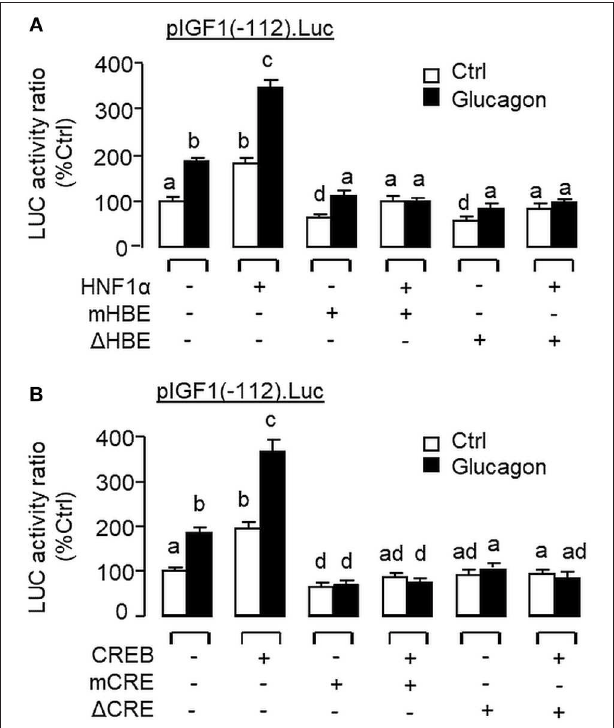
FIGURE 14 | Functional role of HBE and CRE sites within the proximal promoter of IGF-I gene in glucagon-induced IGF-I promoter activity in α T3 cells. Site-directed mutation and PCR-based truncation were conducted in (A) the HBE site (as “mHBE” and “ 1 HBE,” respectively) and (B) CRE site (as “mCRE” and “ 1 CRE,” respectively) within the IGF-I promoter of pIGF1(-112).Luc. After that, the constructs with HBE and CRE mutation/truncation were used for co-transfection studies in α T3 cells together with the expression vector for HNF1 α and CREB, respectively, followed by a 24-h treatment with glucagon (100nM). In these experiments, parallel transfection with the wild type pIGF1(-112).Luc was used as the control. After drug treatment, cell lysate was prepared and used for luciferase activity measurement.